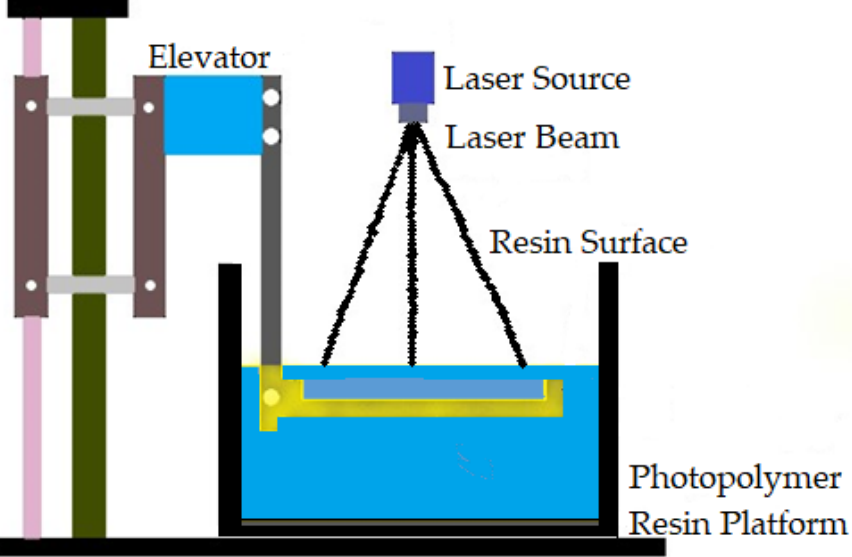
Figure 4. Vat polymerization technique.